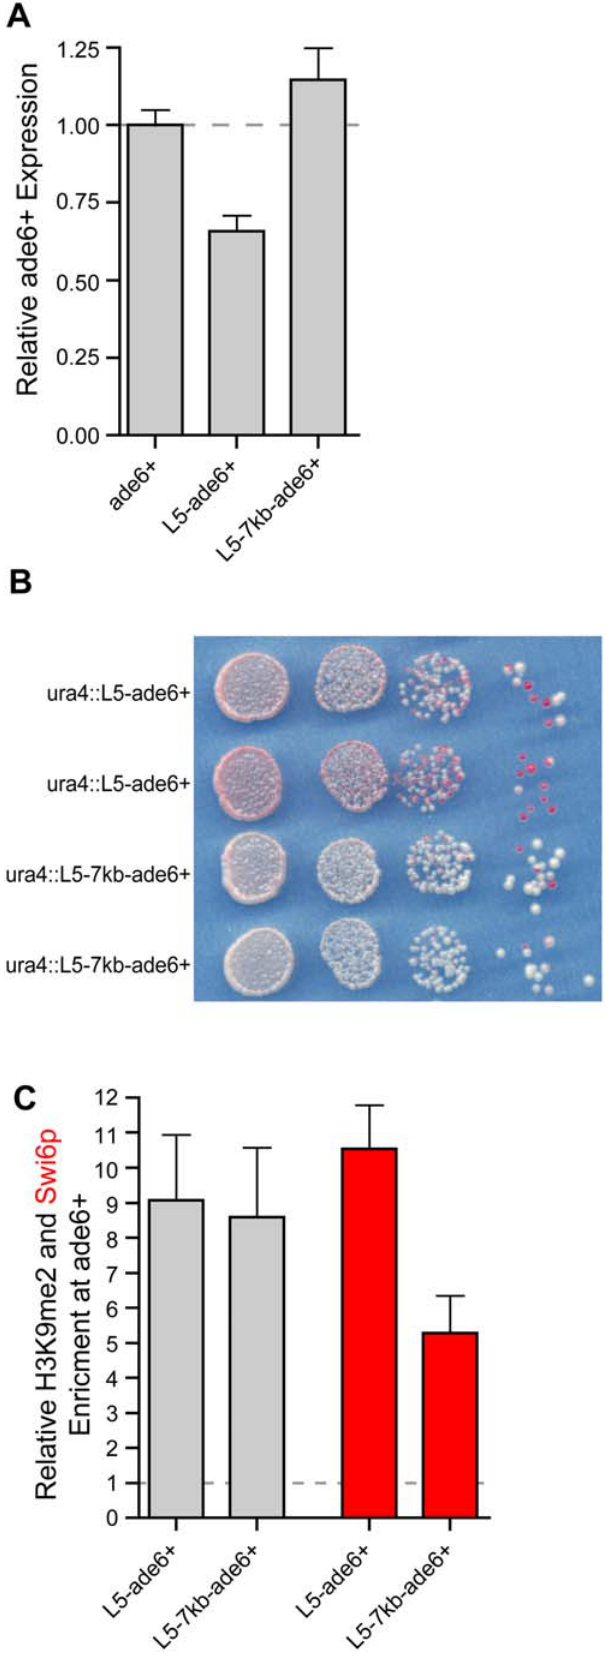
Figure 5. Local versus spreading over spacer DNA exerts different effects on ade6 + expression. (A) Levels of ade6 + expression in control ( ura4 :: ade6 + ) strains compared to both ura4 ::L5- ade6 + and ura4 ::L5-7kb- ade6 + strains. (B) Serial dilution assay